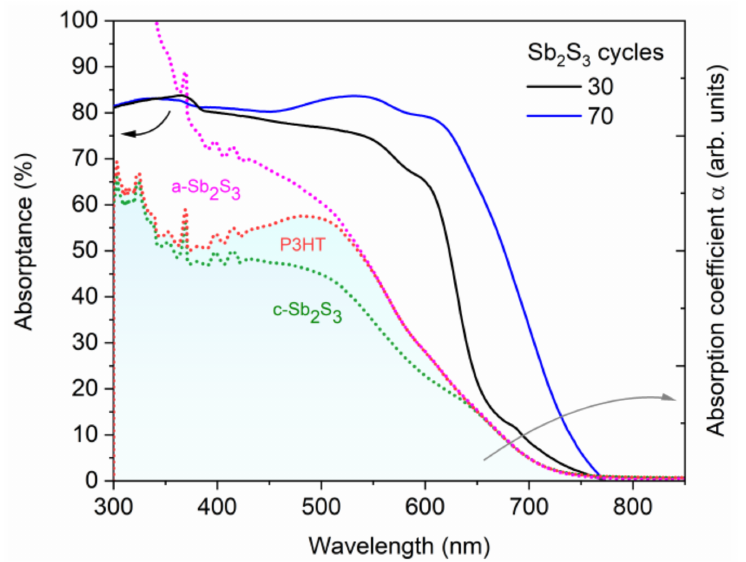
Figure 11. Absorptance (solid lines) of the best ETA solar cells made of ZnO/TiO 2 core–shell NW heterostructures covered with a Sb 2 S 3 shell grown by CSP, using 30 and 70 cycles, and topped by P3HT. Absorption coefficient, α (dashed lines), of each layer and of the expected additional phase (a-Sb 2 S 3 ) in the ETA cell. The absorption coefficients of P3HT and amorphous Sb 2 S 3 (a-Sb 2 S 3 ) were elevated above crystalline Sb 2 S 3 (c-Sb 2 S 3 ) and P3HT, respectively, to illustrate the cumulative effect of each added layer on the optical density of the ETA